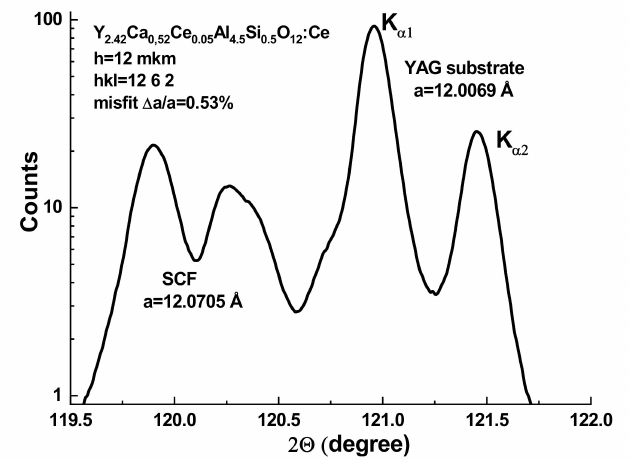
Figure 3. XRD patterns of (1262) planes of Y 2.43 Ca 0.52 Ce 0.05 Al 4.5 Si 0.5 O 12 SCF, LPE grown onto YAG substrate from melt solution with YCa 2 Al 3 Si 2 O 12 :Ce nominal content (see Table